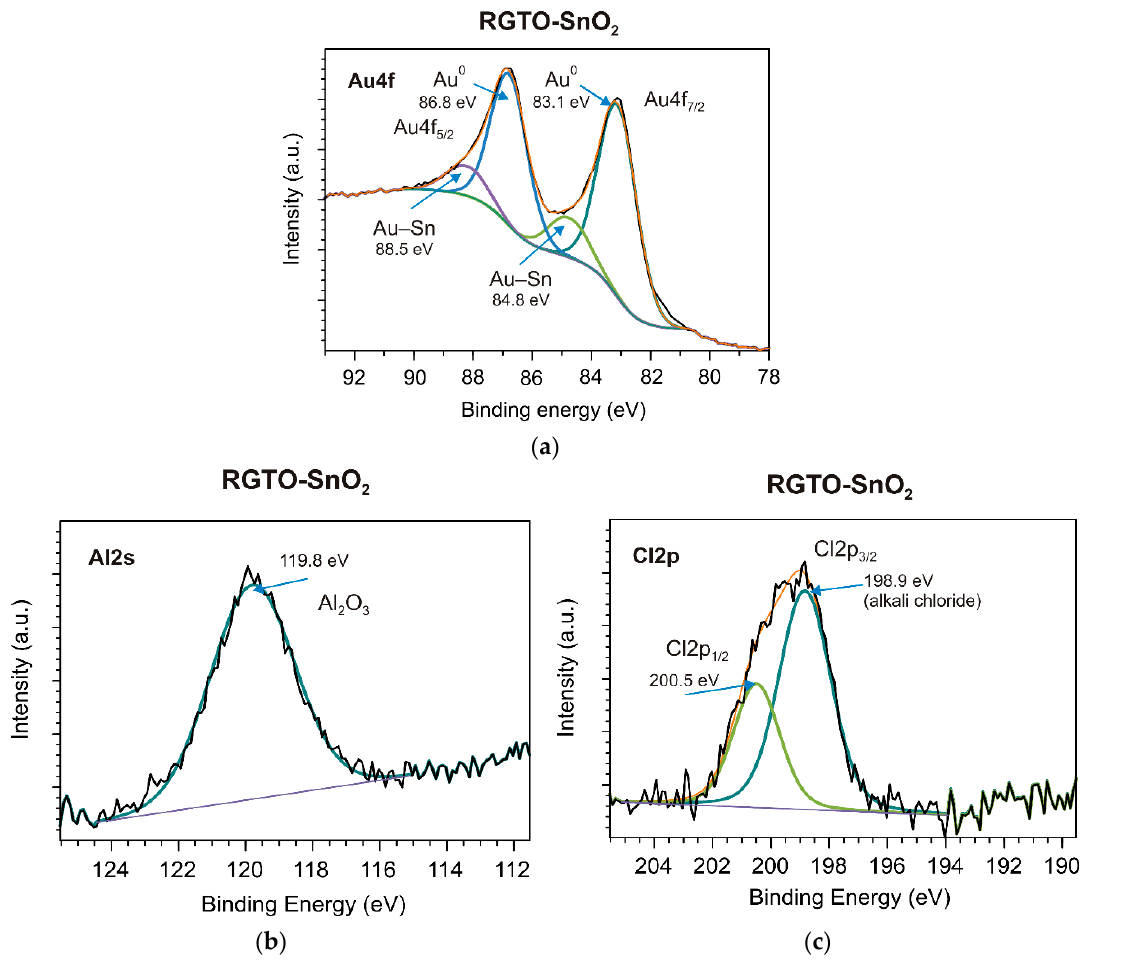
Figure 11. ( a ) Au 4f, ( b ) Al 2s, and ( c ) Cl 2p core-level XPS spectra of the RGTO-SnO 2 film.